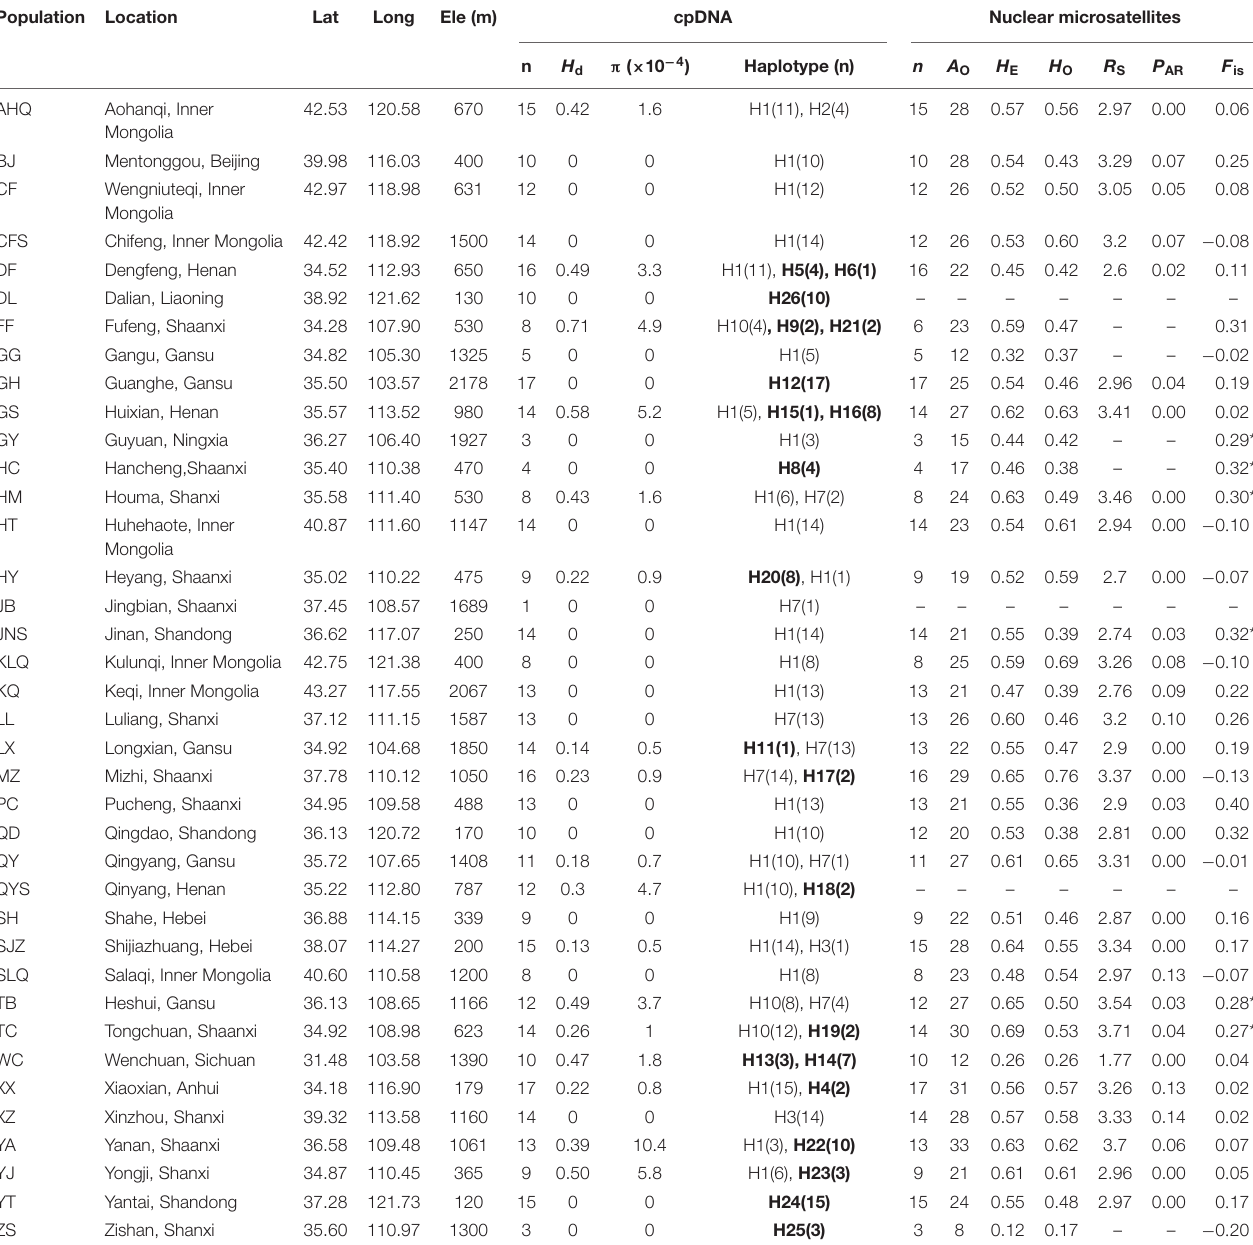
TABLE 1 | Details of sample location, sample size, and genetic diversity of chloroplast DNA and nuclear microsatellites in 38 Speranskia tuberculata populations. Population Location Lat Long Ele (m)